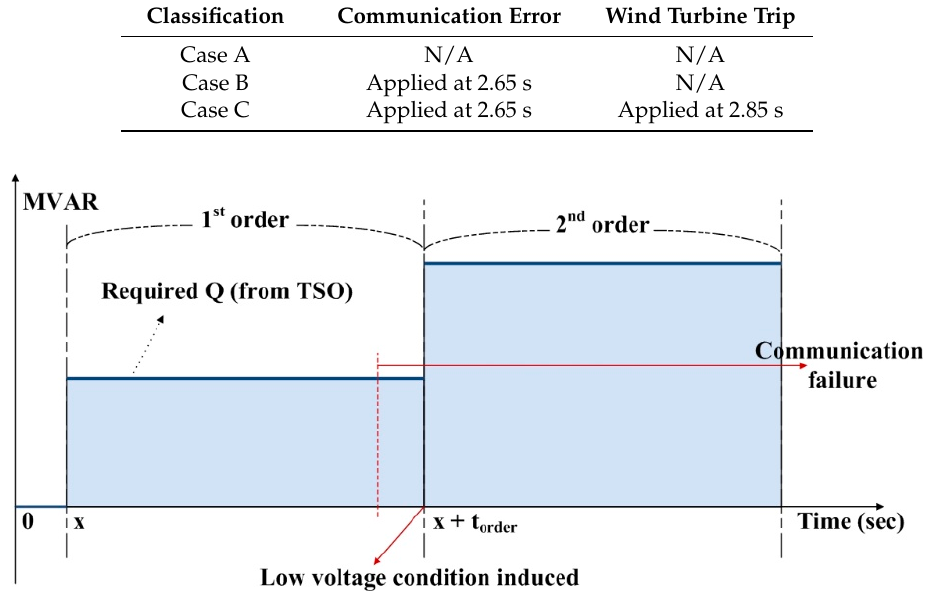
Figure 6. Reactive power control concept in simulated scenarios. Appl. Sci. 2018 , 8 , 68